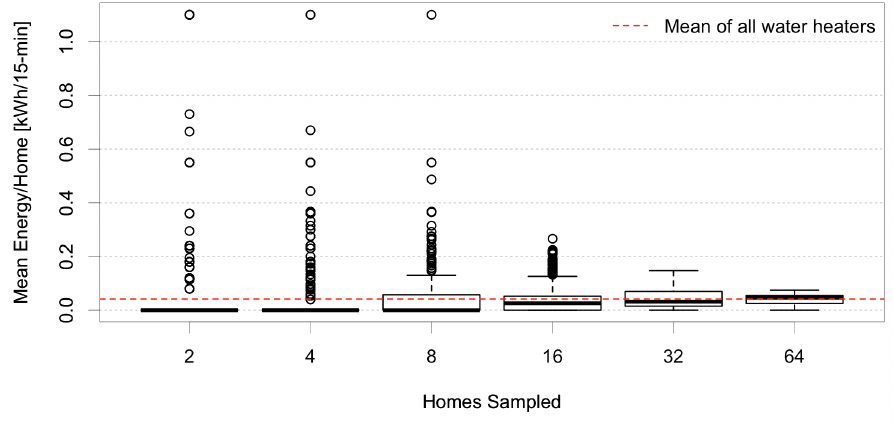
Figure 4. Bounds of electric energy usage for heating DHW over interval 00:00 to 00:15 on 04-01-2012. Moving left to right towards more houses being sampled, note the tighter bounds, fewer outliers, and the median values approaching the mean energy usage of all electric water heaters.